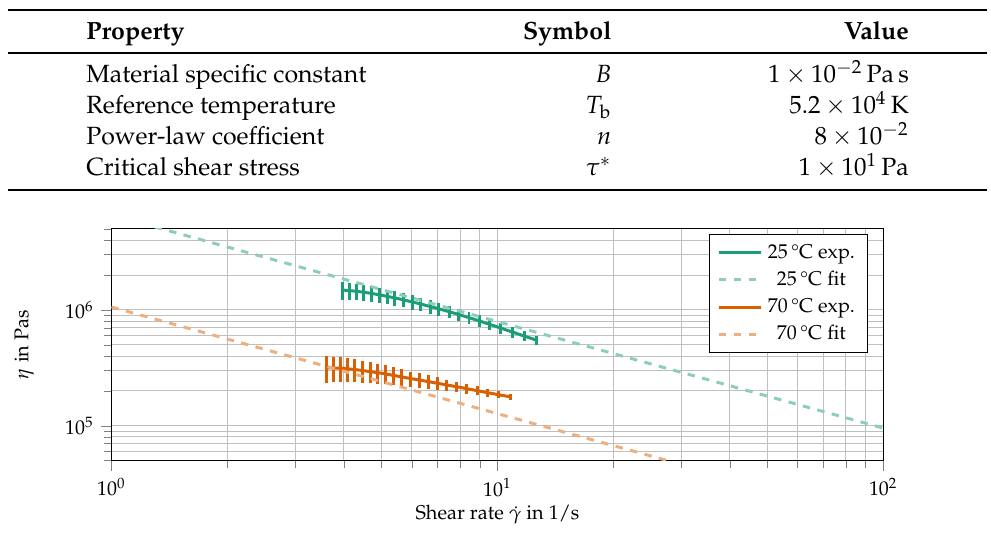
Figure A1. Average of the viscosity η (solid lines) of three press rheometry samples vs. shear rate ˙ γ of the SMC at T = 25°C and T = 70°C. The dashed lines indicate the viscosity function described by the Cross–Andrade model and the fit parameters shown in Table A2. Table A3. µCT parameters.